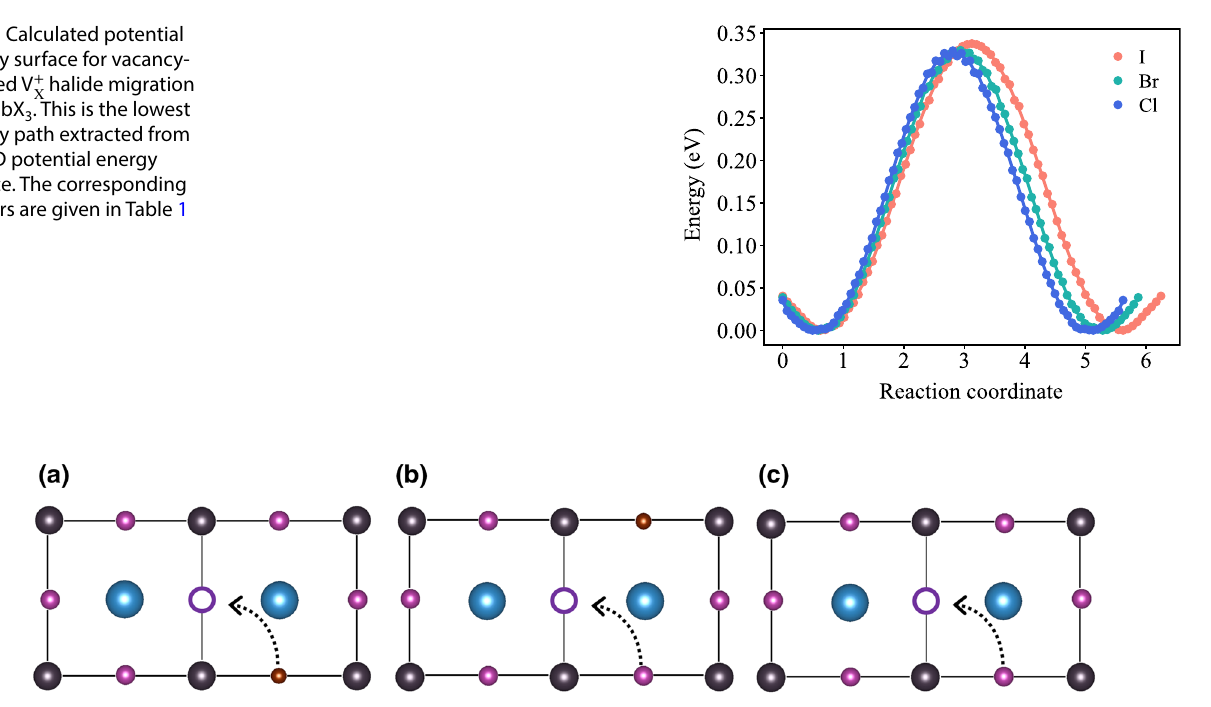
Fig. 3 Diffusion models considered in mixed halide systems. Pathway for iodine vacancy migration (purple circle) with: a a bromine ion in